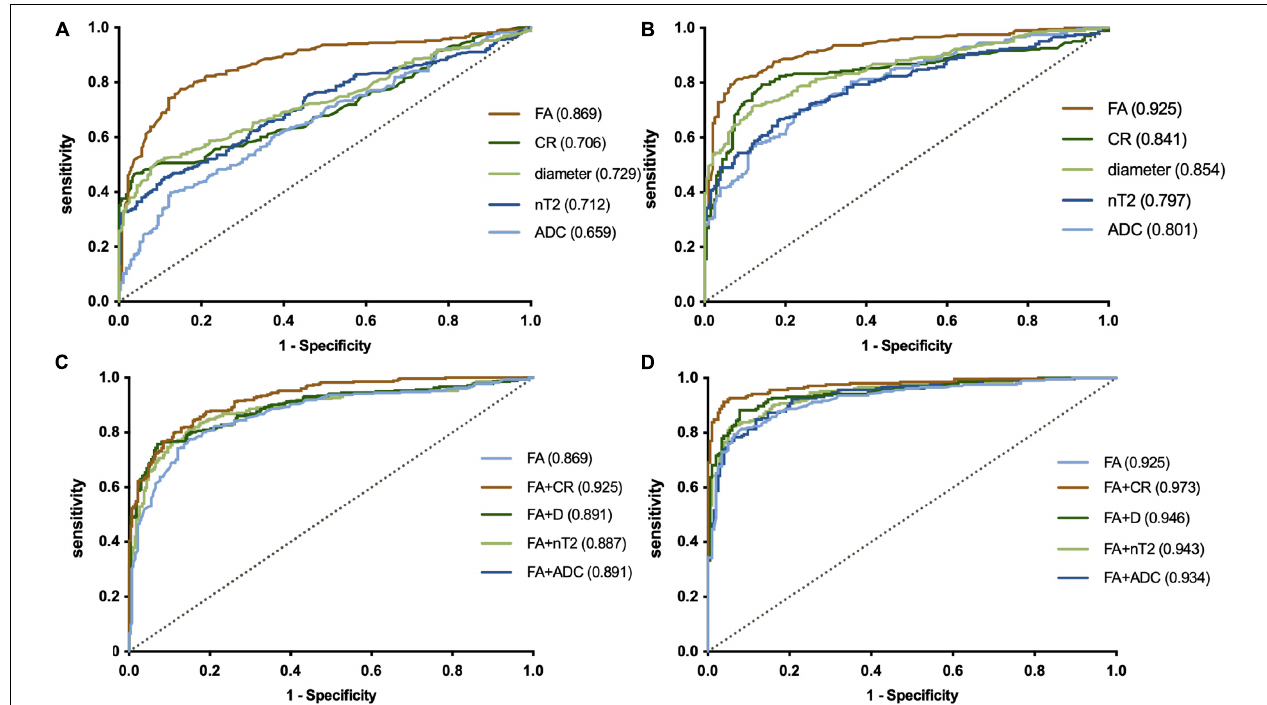
FIGURE 5 | ROC plots revealing the performance of a single-parameter model in the plexus ( A , brachial plexus; B , LS plexus) and the combined model in the plexus ( C , brachial plexus; D , LS plexus). The largest AUC was 0.925, using the cutoff value of 0.361 for the fractional anisotropy (FA) of the LS plexus in a single-parameter model (B) . The combined analysis demonstrated that the combination of FA and the contrast-enhanced ratio has the largest AUC (0.973) in the LS plexus (B) . LS, lumbosacral. The numbers in parentheses indicate the respective AUC